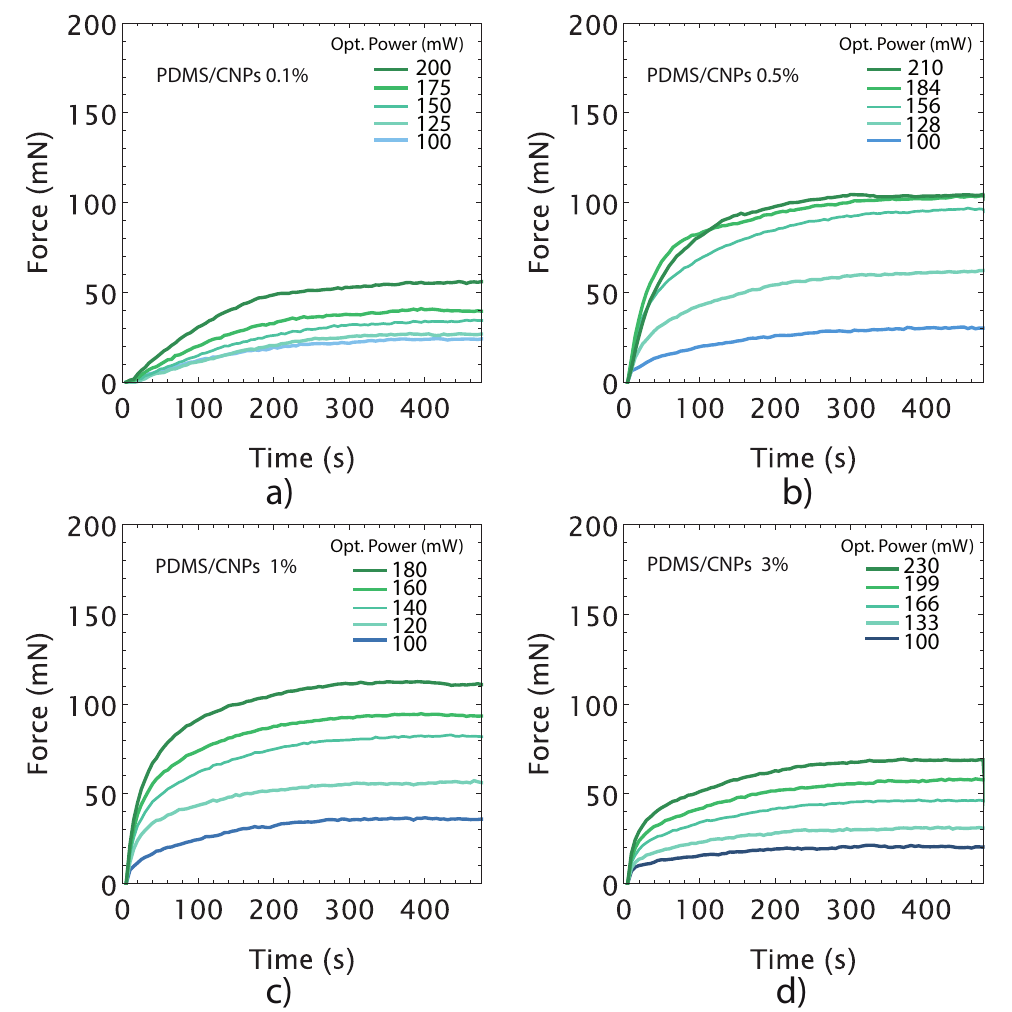
Figure 7. Optically driven forces produced by nanocomposites as a function of time for differ- ent optical power outputs: ( a ) PDMS/CNPs 0.1% considering an optimal distance d = 5 mm; ( b ) PDMS/CNPs 0.5% considering an optimal distance d = 9 mm; ( c ) PDMS/CNPs 1% considering an optimal distance d = 10 mm; and ( d ) PDMS/CNPs 3% considering an optimal distance d = 16